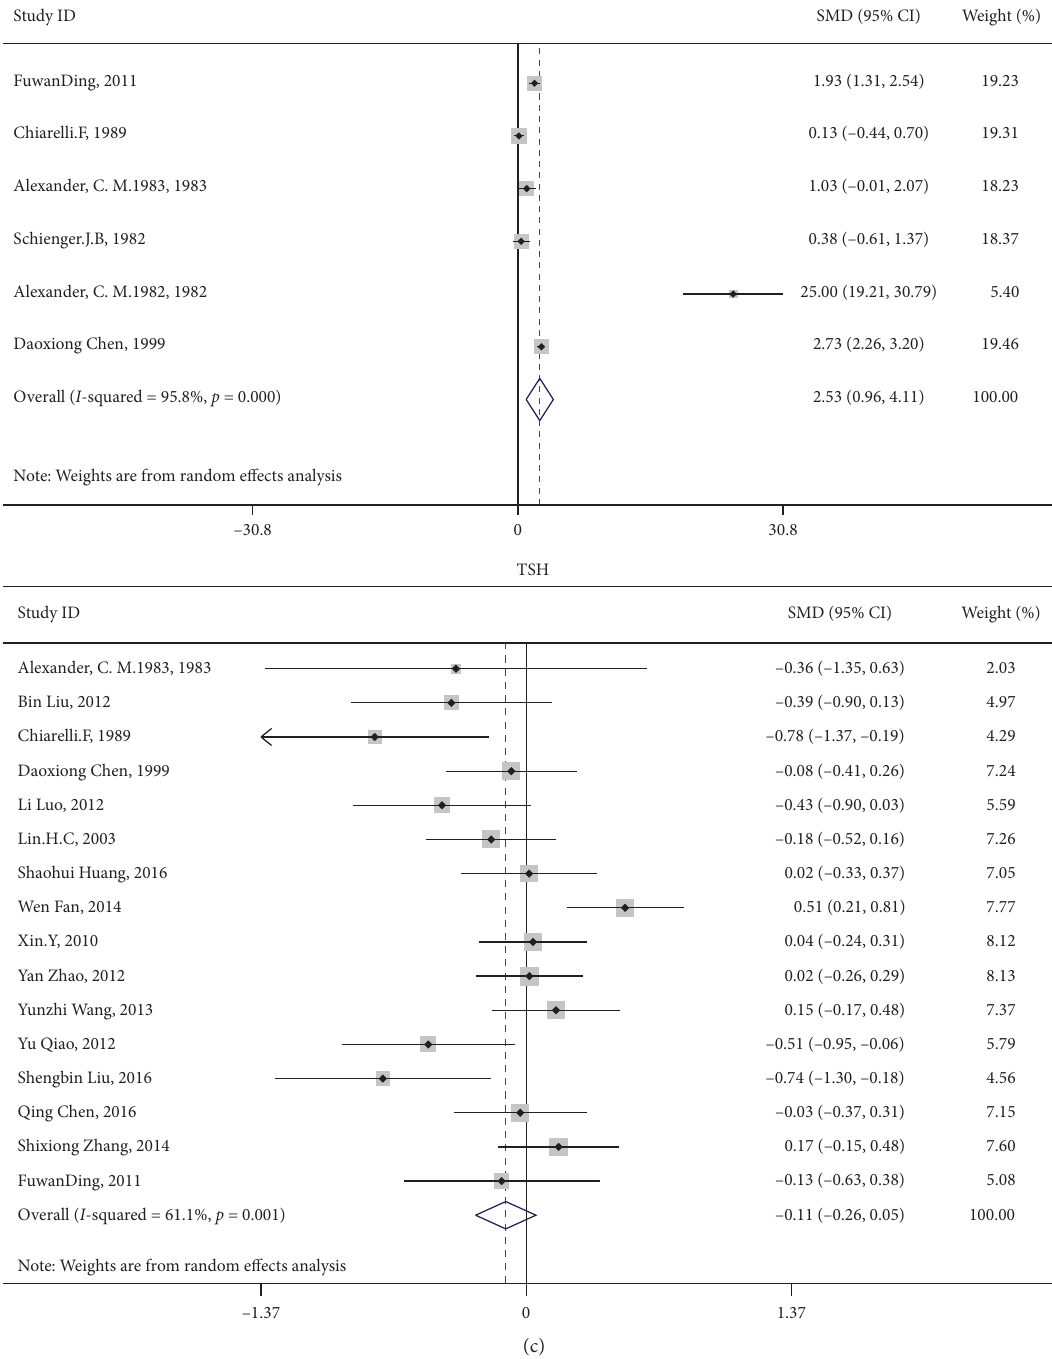
Figure 2: Forest plot of T4, T3, FT4, FT3, rT3, and TSH compared with patients with DKA and